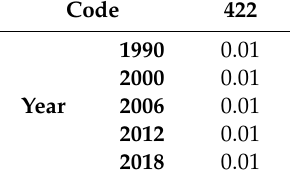
Table 7. Percentage of water bodies according to CORINE land-cover nomenclature for level 3 in Poland in Canary Islands in 1990, 2000, 2006, 2012 and 2018 (Source: authors). Code